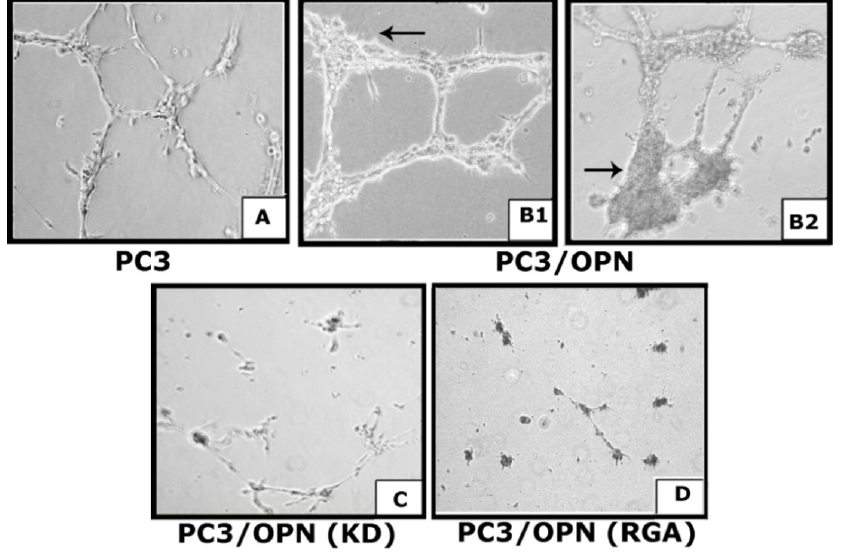
Figure 2. Secreted OPN and VEGF promote endothelial cell migration and microvascular tube formation in vitro . Phase contrast micrograph showing tube formation in vitro by HMEC-1 cells. HMEC-1 cells were grown on matrigel and incubated with conditioned media from indicated PC3 cells for 24 h. Images were captured (×200) with an inverted phase contrast microscope. Results shown are representative of three independent